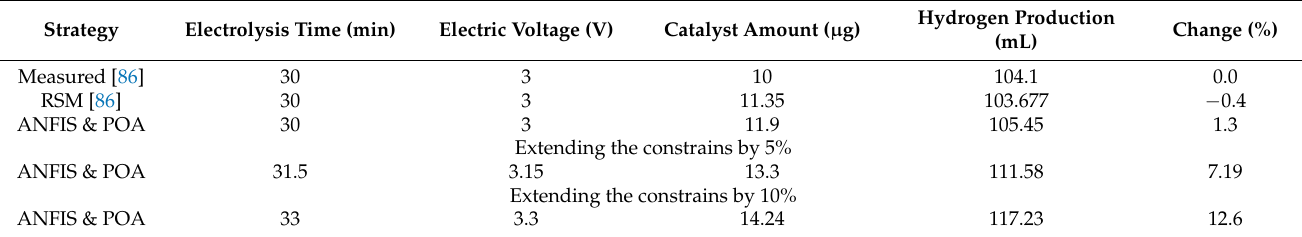
Table 6. Optimum parameter values using the considered methods.